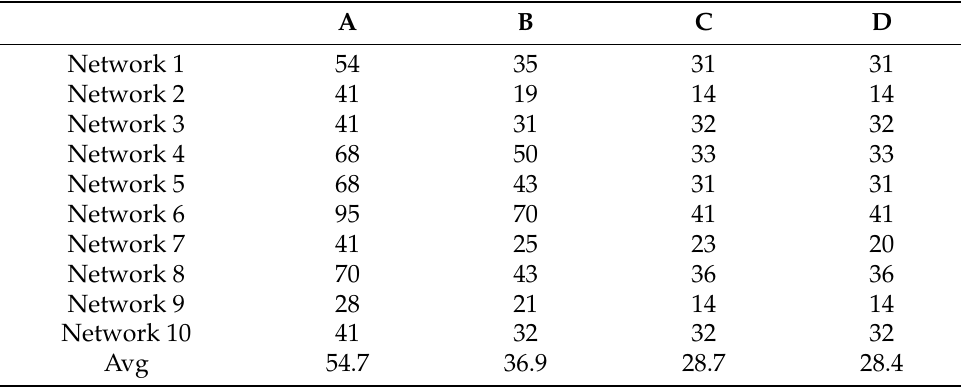
Table 2. Optimized frame sizes for small networks